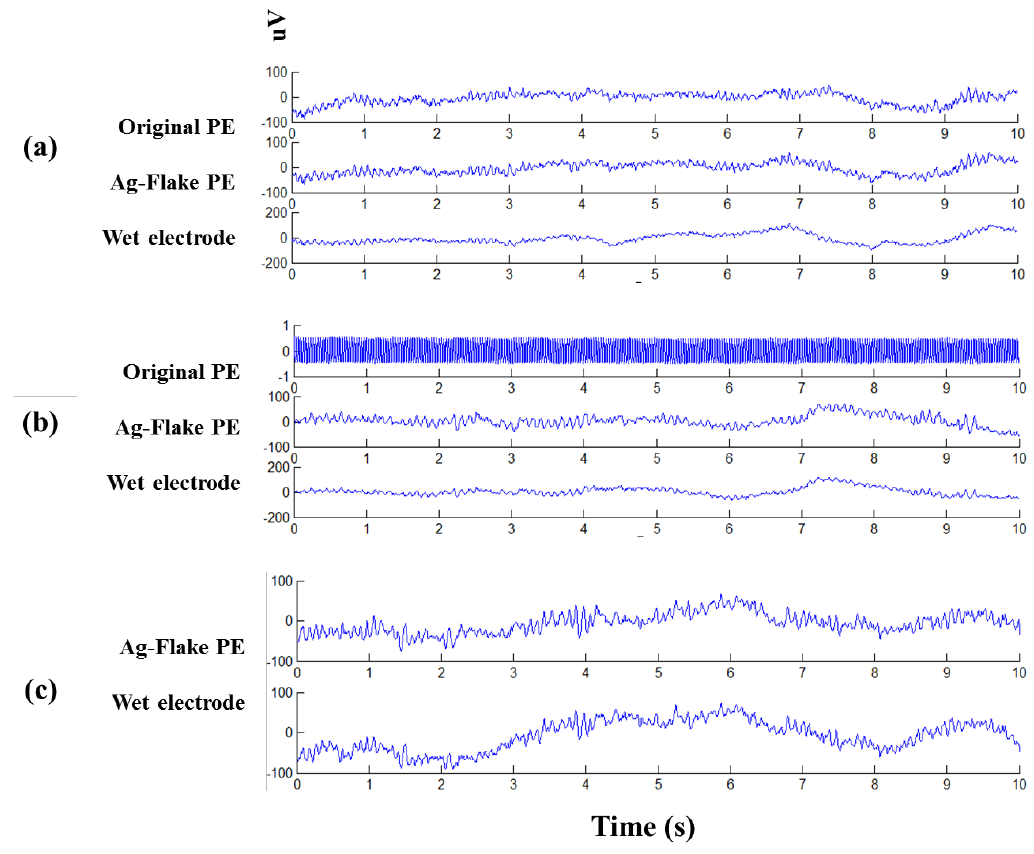
Figure 8. Synchronic EEG tracings of eyes closed conditions for different electrodes (original PE, Ag-flake PE, and wet electrode) underwent the salt spray test in ( a ) 0.3%, ( b ) 3.0%, and ( c ) 5.0% saline solution.